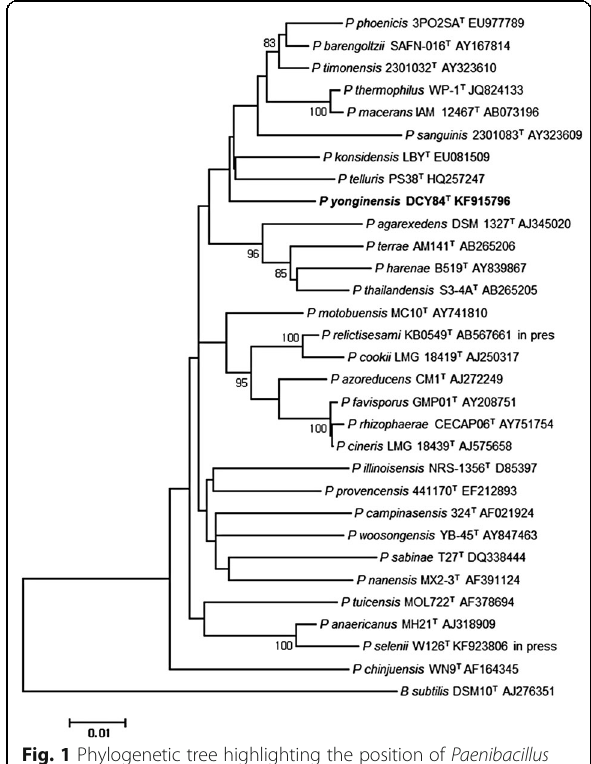
Fig. 1 Phylogenetic tree highlighting the position of Paenibacillus yonginensis DCY84 T relative to other Paenibacillaceae family type strains. GenBank accession numbers are indicated in parentheses.